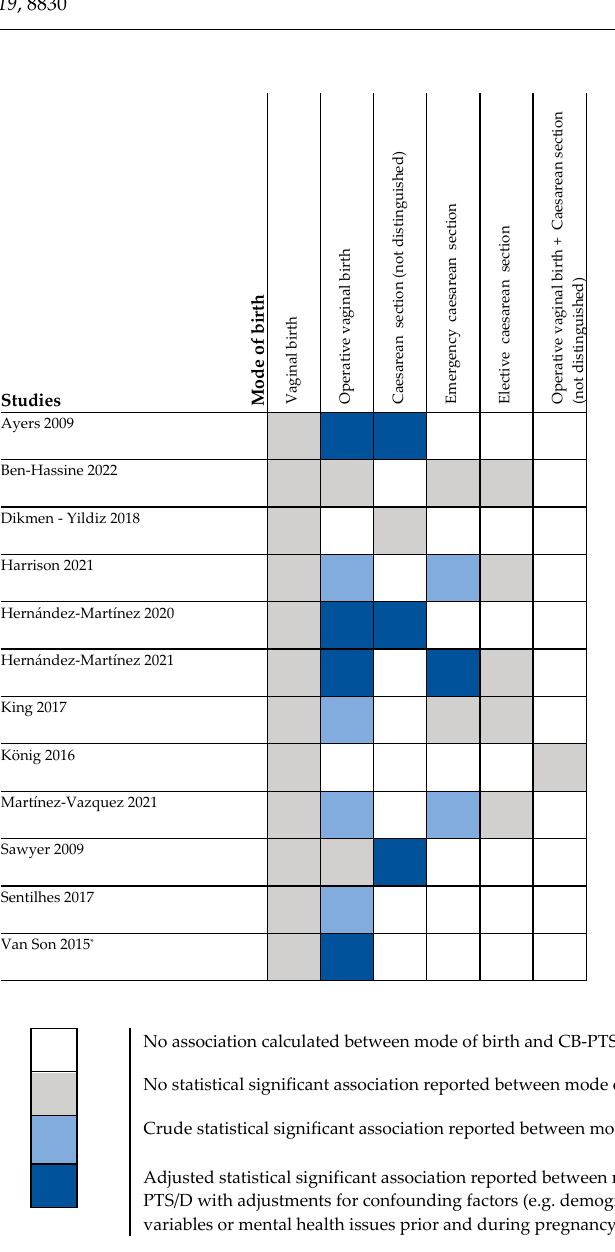
Figure 3. Associations between mode of birth and CB-PTS/D ( ≥ 6 months postpartum). * Significant Figure 3: Associations between mode of birth and CB-PTS/D ( ≥ 6 months postpartum) * Significant association association reported at 6 months postpartum not at 12 months